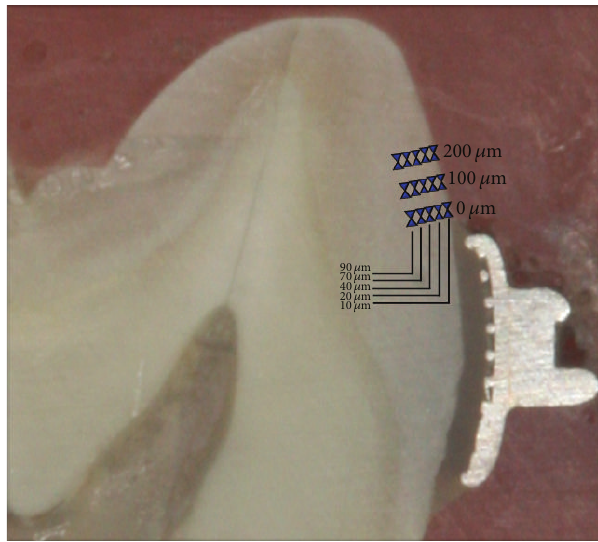
Figure 1: Positions and depths of indentations.